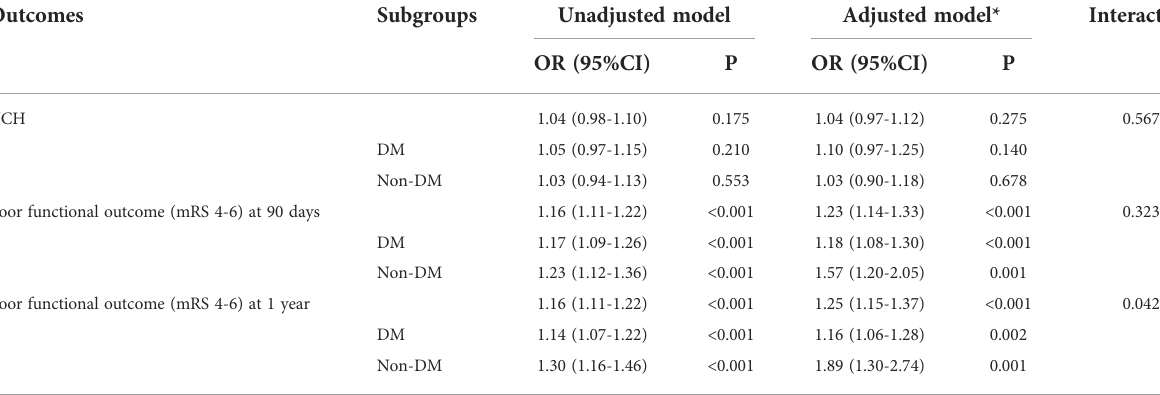
TABLE 3 The associations between short-term GV and